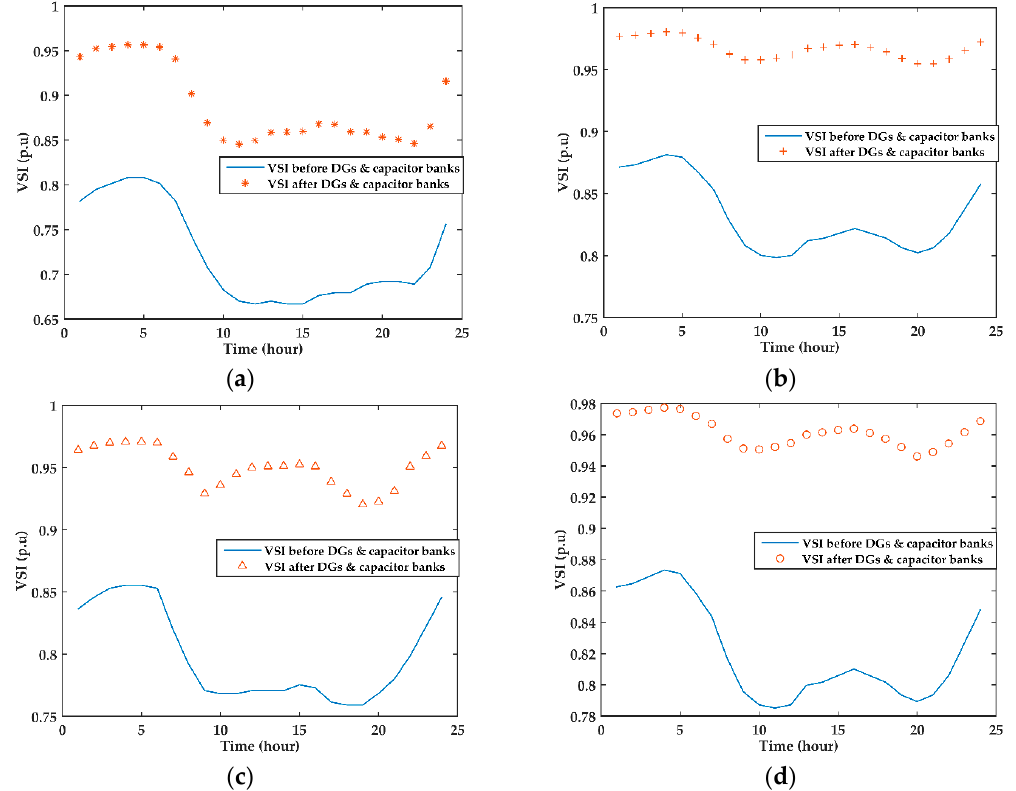
Figure 10. ( a ) Summer; ( b ) autumn; ( c ) winter and ( d ) spring average minimum VSI values before and after DGs installation of DGs and capacitor banks